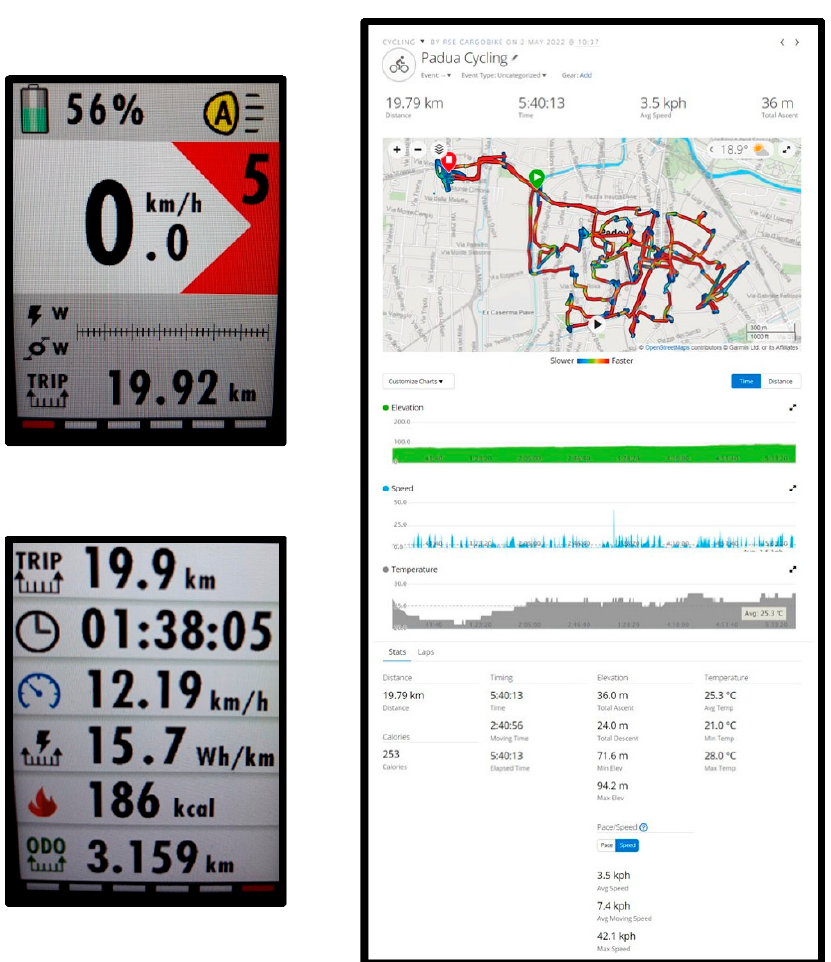
Figure 4. Data and information collected during a delivery working day, using the GPS and the other sensors deployed on the e-cargo bike.